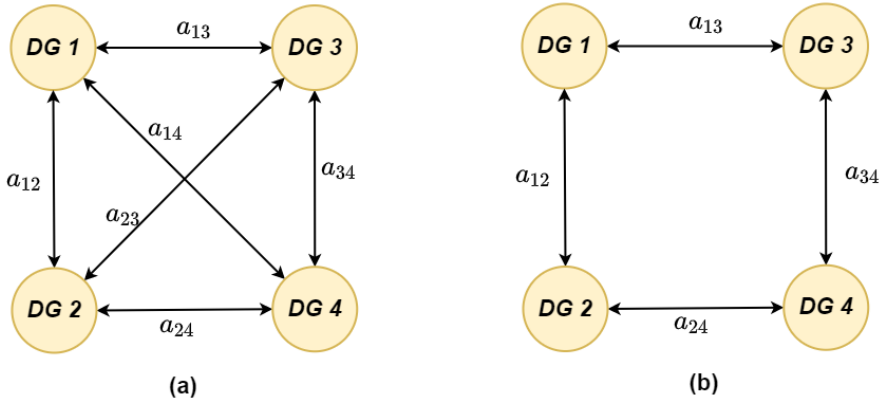
Figure 5. ( a ) Topology A; ( b ) Topology B.